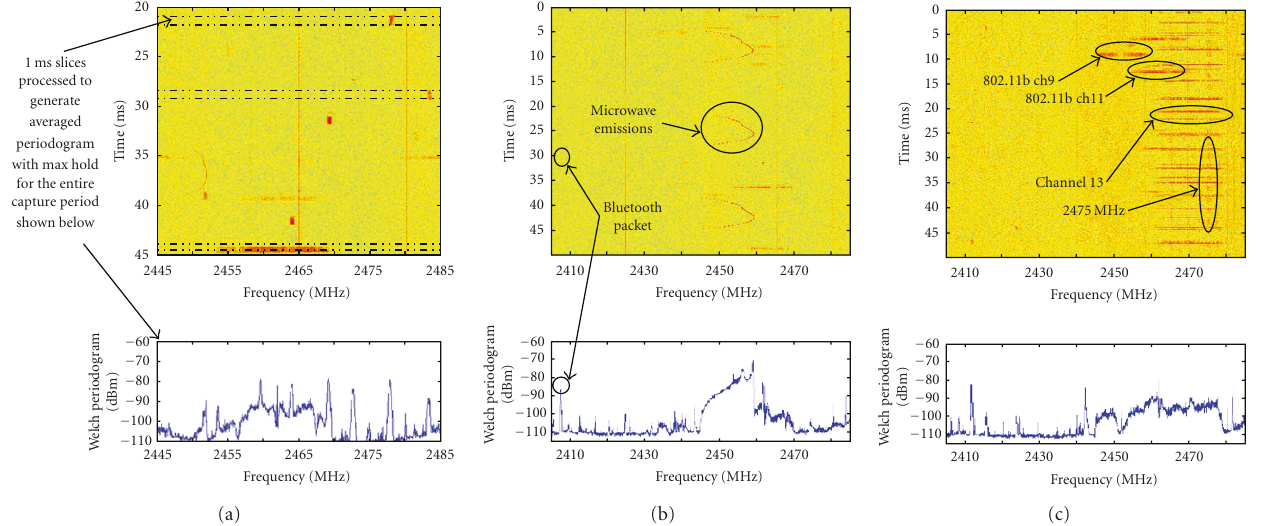
Figure 2: ISM band spectral emission measurement. (a) observations of Bluetooth packet; (b) observations of Bluetooth packets and microwave oven emissions; (c) observation of IEEE 802.11b